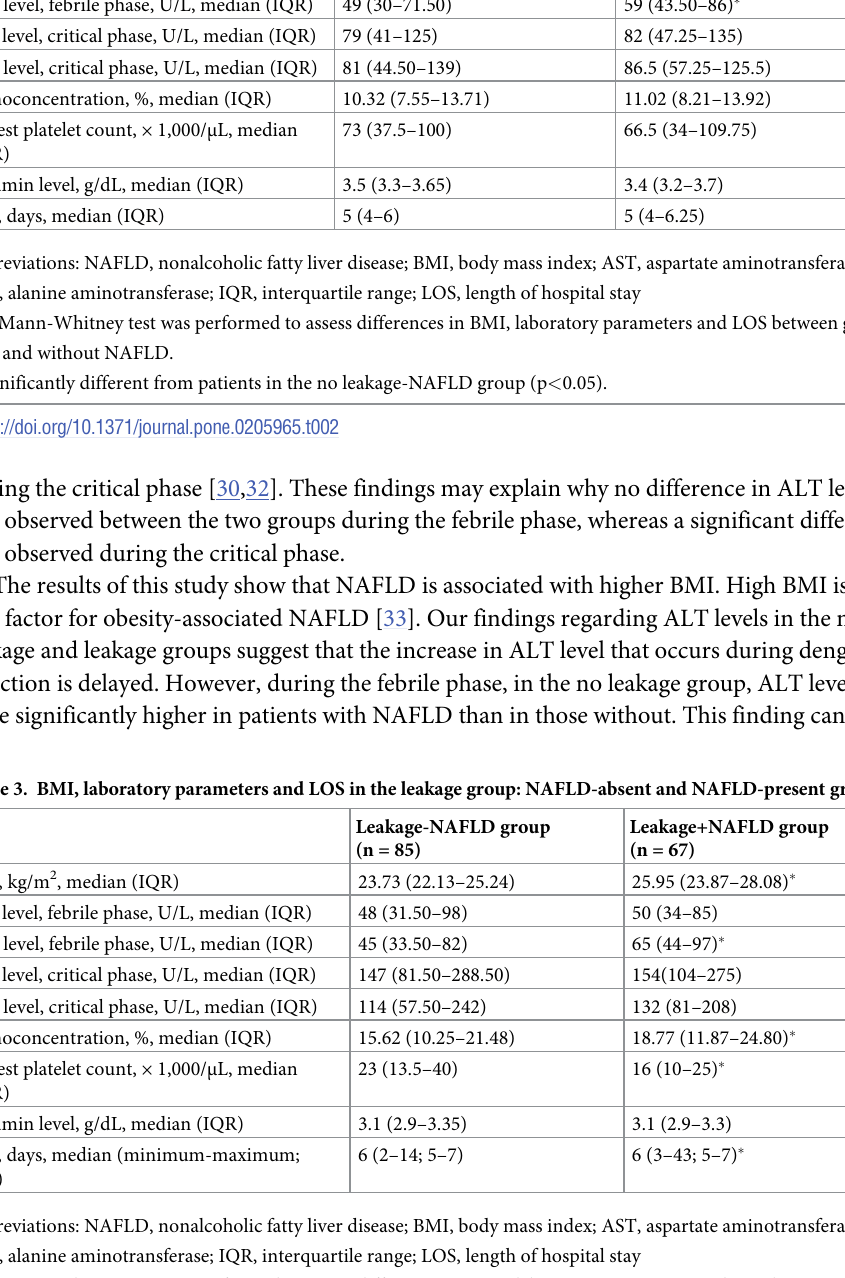
Table 2. BMI, laboratory parameters and LOS in the no leakage group: NAFLD-absent and NAFLD-present groups. BMI, kg/m 2 , median (IQR)